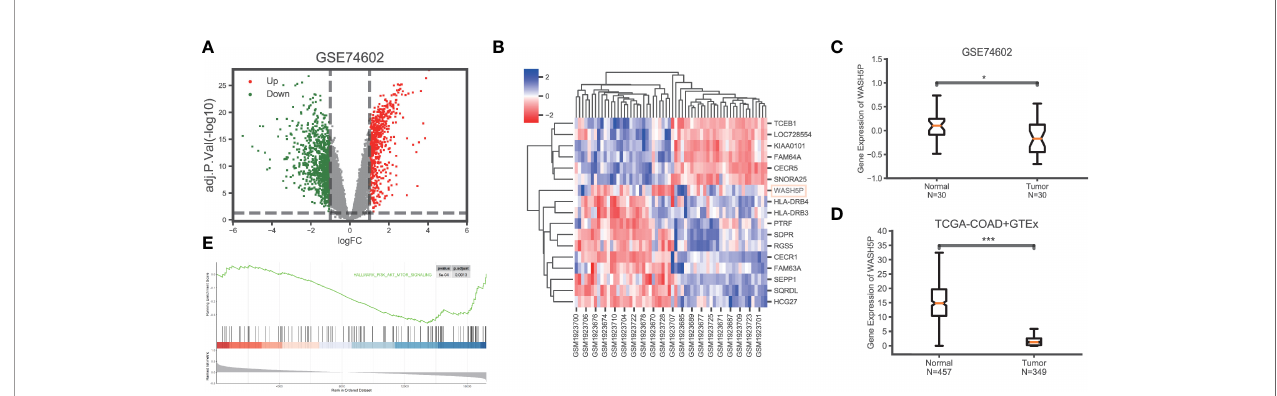
FIGURE 1 | LncRNA WASH5P is downregulated in CRC. (A) Identi fi cation of the differentiated expression of non-coding genes in colorectal cancer based on GSE74602 from the The Cancer Genome Atlas (TCGA) database: a total of 1,639 differentially expressed non-coding genes were screened, including 662 upregulated (the red dots) and 977 downregulated genes (the green dots). (B) Heat maps showing the most differentiated expression genes between colorectal cancer (n=30) and adjacent normal tissues (n=30) from the TCGA data set (GSE74602). The color of the square corresponds to the relative expression among cases. (C) The relative expression of lncRNA WASH5P in CRC tissues (n=30) and adjacent non-tumor colorectal tissues (n=30) was analyzed in data set GSE74602. (D) WASH5P expression levels in cancer tissues (n=349) and normal tissues (n=457) in the database from TCGA-COAD and GTEx.***. Correlation is signi fi cant at the 0.001 level. (E) GSEA analysis showed that lncRNA WASH5P was enriched in the hallmark PI3K-AKT